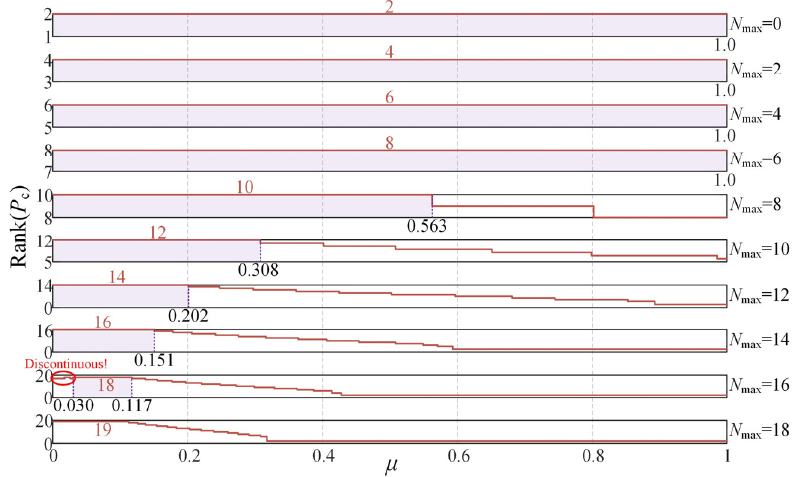
Figure 5. The relationship between the rank of controllability matrix P c and controllability factor µ under various N max .